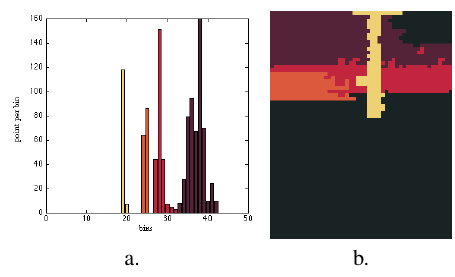
Figure 4. Result of the histogram segmentation using (Delon et al., 2007). (a) segmented histogram (bins of 50cm), (b) result in the range image using the same colors.